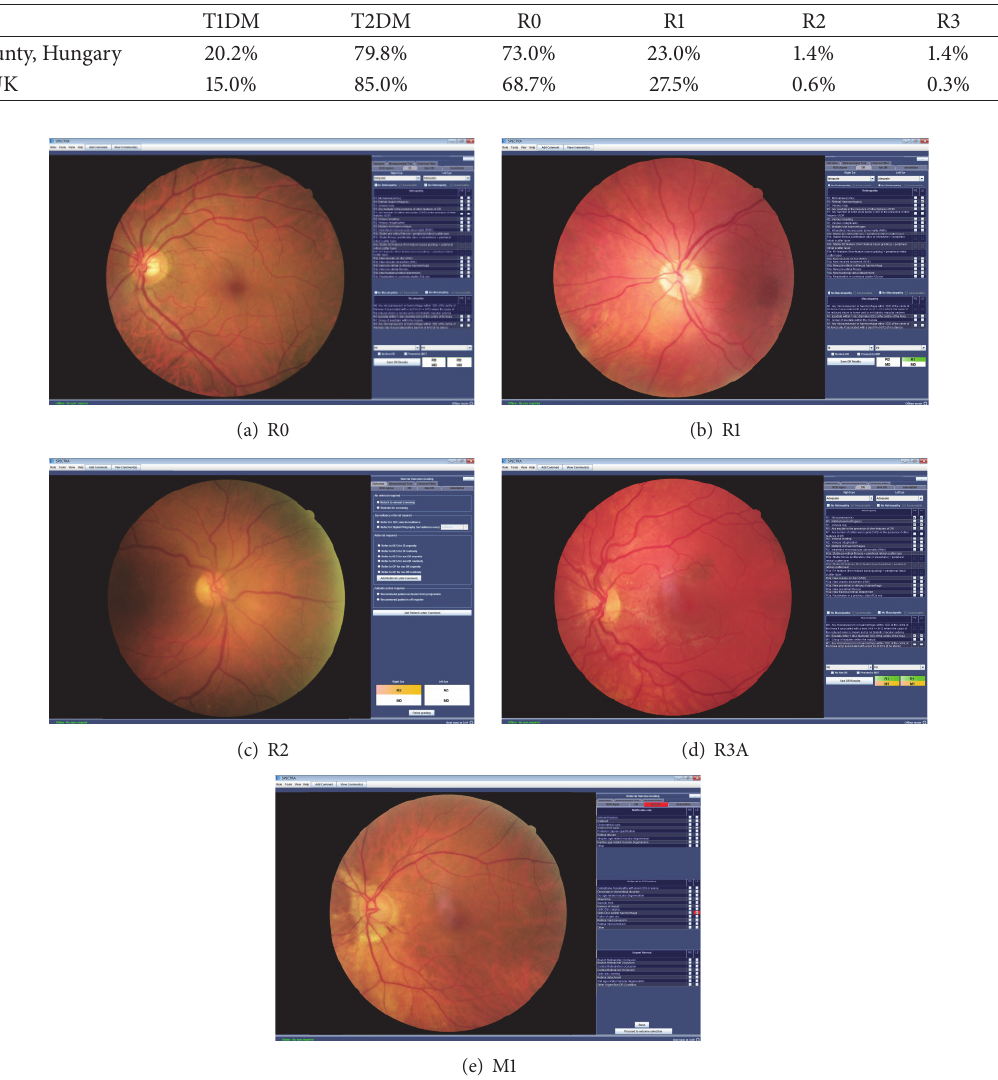
Figure 1: Spectra DR based grading of the DR retinopathy. Representative images of the different grading stages are shown in the studied